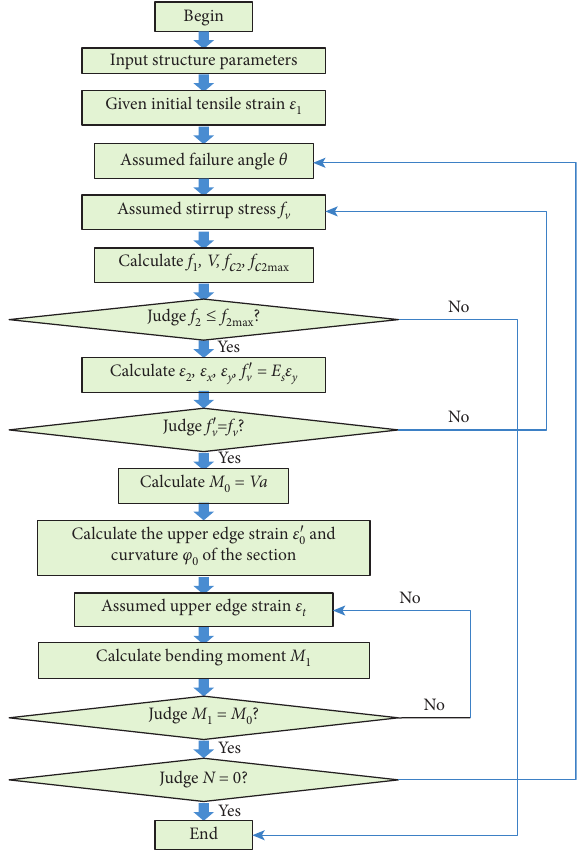
Figure 9: Block diagram of the calculation